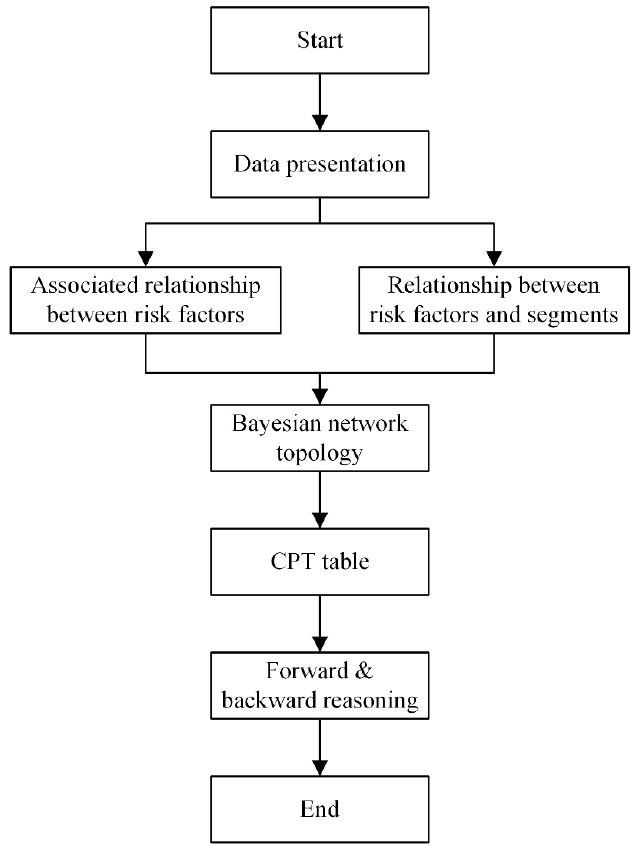
Figure 2. Identification flowchart of the delayed delivery risk transmission path.